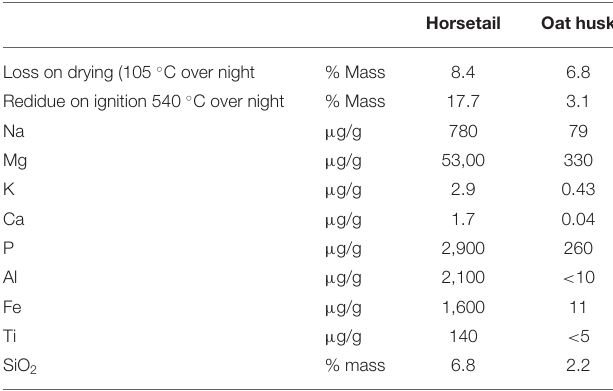
TABLE 1 | Quantitative analysis of both horsetail and oat husk from samples “as received”.